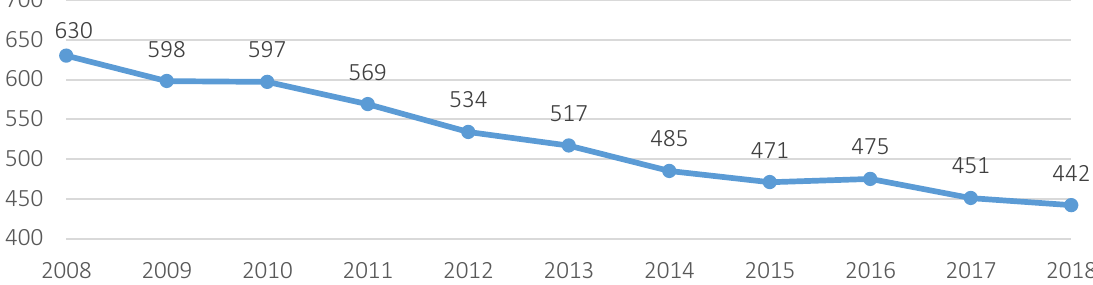
Figure 8. The number of students in higher education establishments in Odesa region in